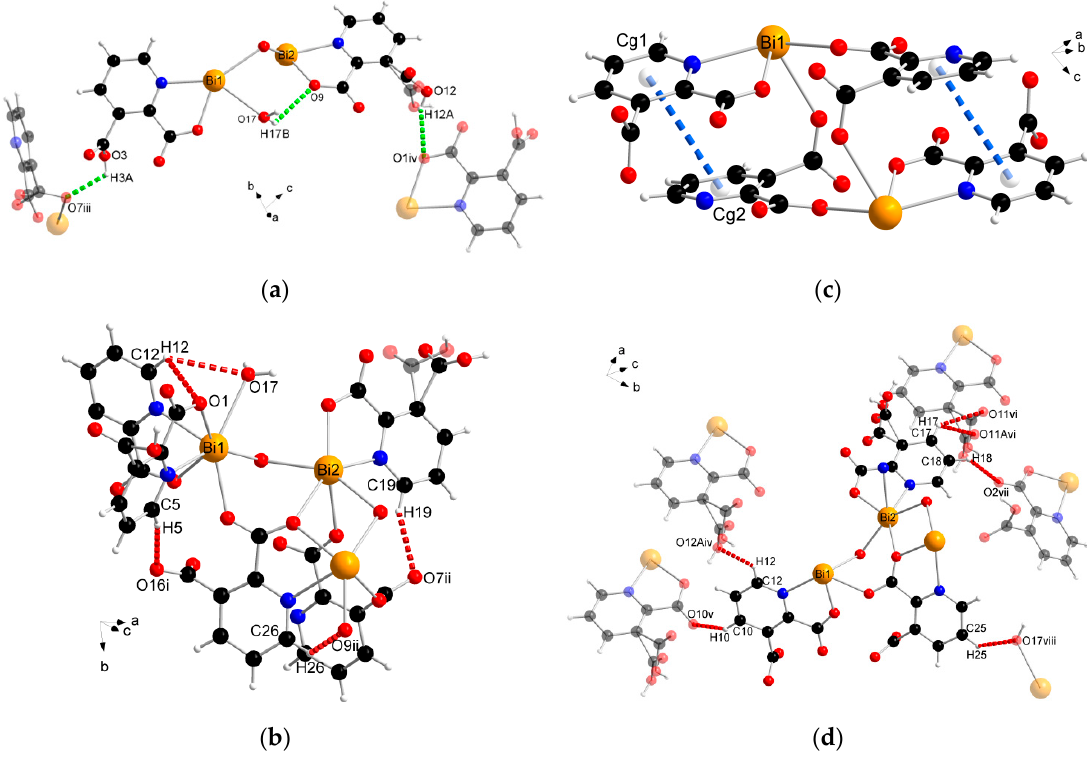
Figure 4. The geometry of noncovalent interactions in complex 1 : ( a ) O–H ∙∙∙ O, ( b ) C–H ∙∙∙ O Figure 4. intramolecular, ( c ) π∙∙∙π and ( d ) C–H ∙∙∙ O intermolecular (translucent molecules belong to adjacent